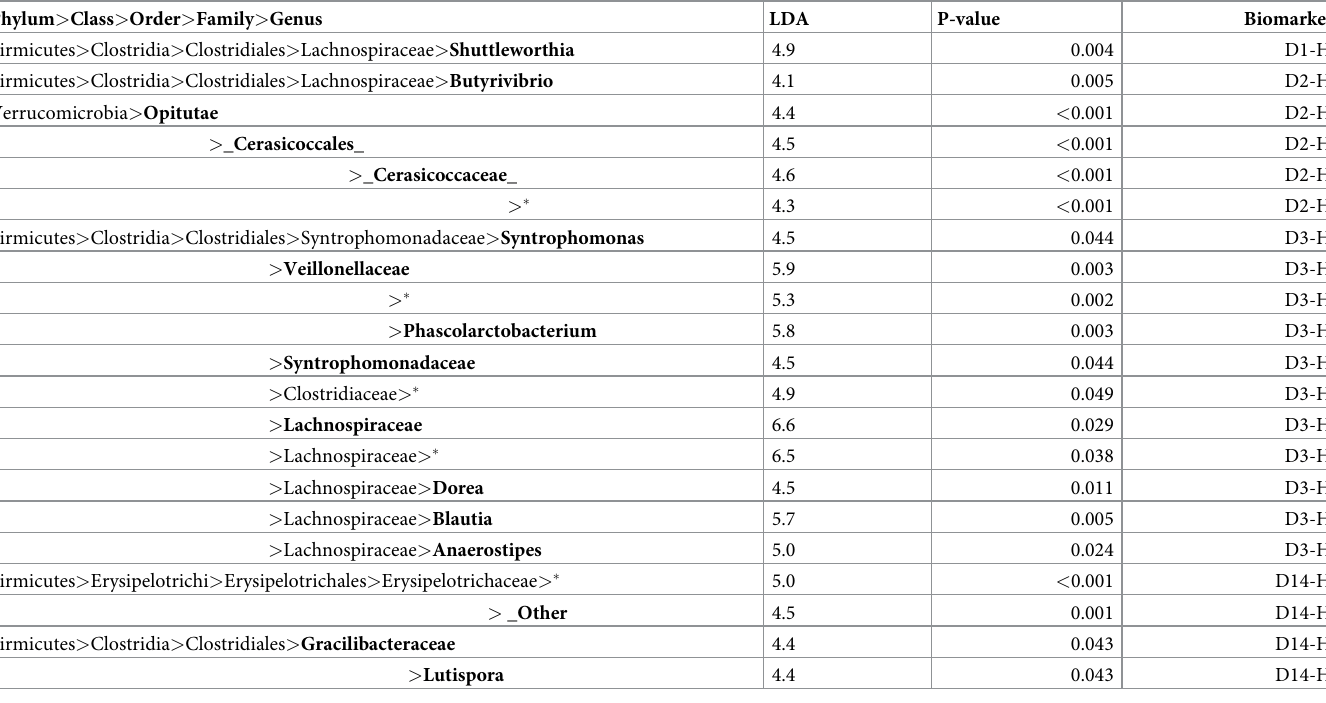
� indicates unclassified taxonomic level. LDA: linear discriminate analysis